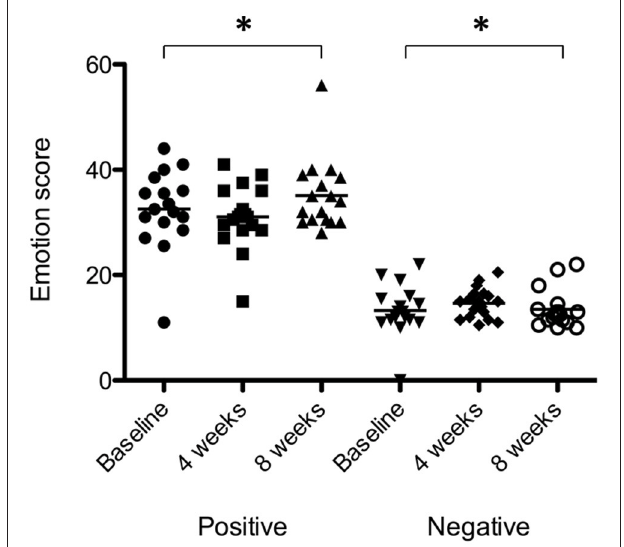
FIGURE 9 | Positive emotionality and negative emotionality scores at baseline (filled circles for positive emotionality; inverted triangles for negative emotionality), at 4 weeks follow-up (squares for positive emotionality; diamonds for negative emotionality) and at 8 weeks follow-up (triangles for positive emotionality; open circles for negative emotionality). Horizontal lines represent average scores. Significant differences are indicated by * p < 0.05.